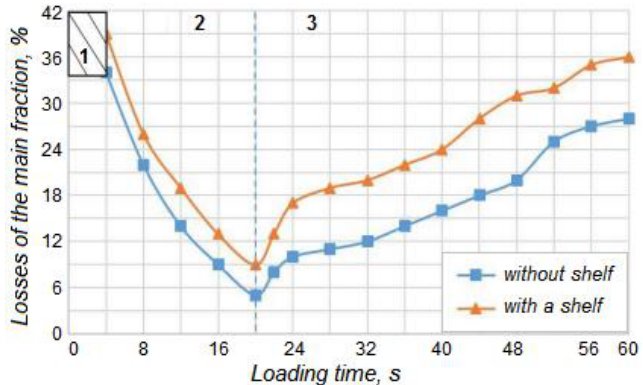
Figure 5. Losses of the main fraction during the pneumatic classification process: 1 — continuous loading; 2 — operating area; 3 — flow fracture.